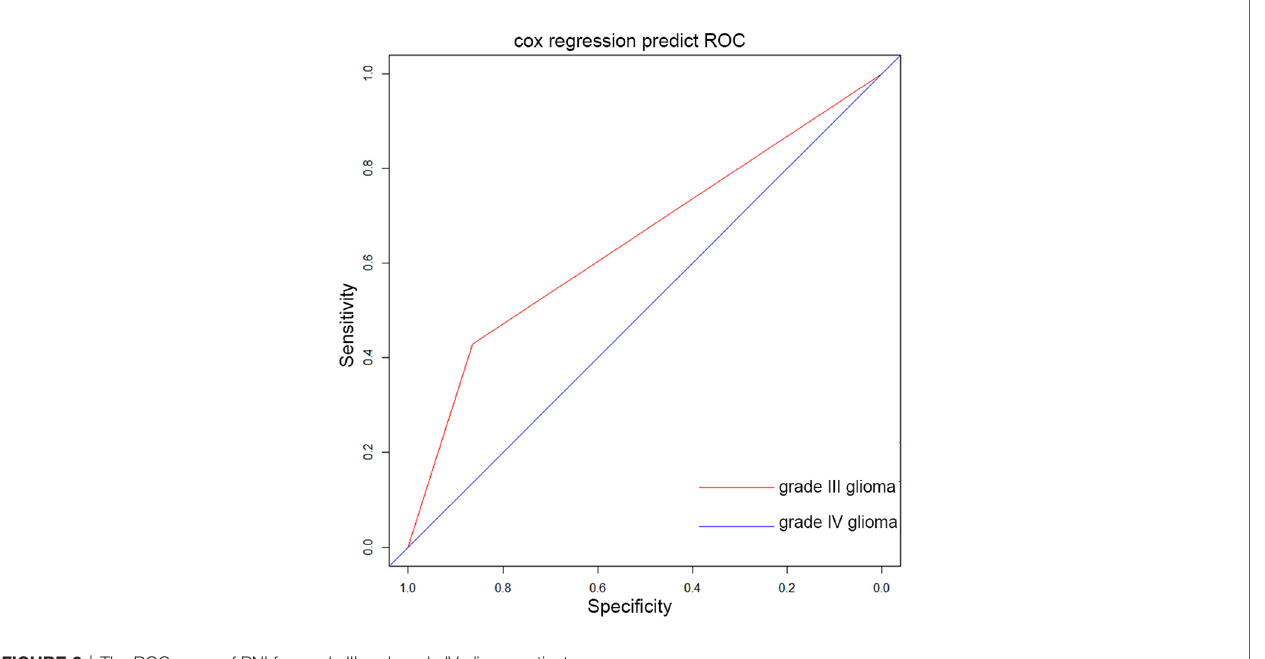
FIGURE 2 | The ROC curve of PNI for grade III and grade IV glioma patients.